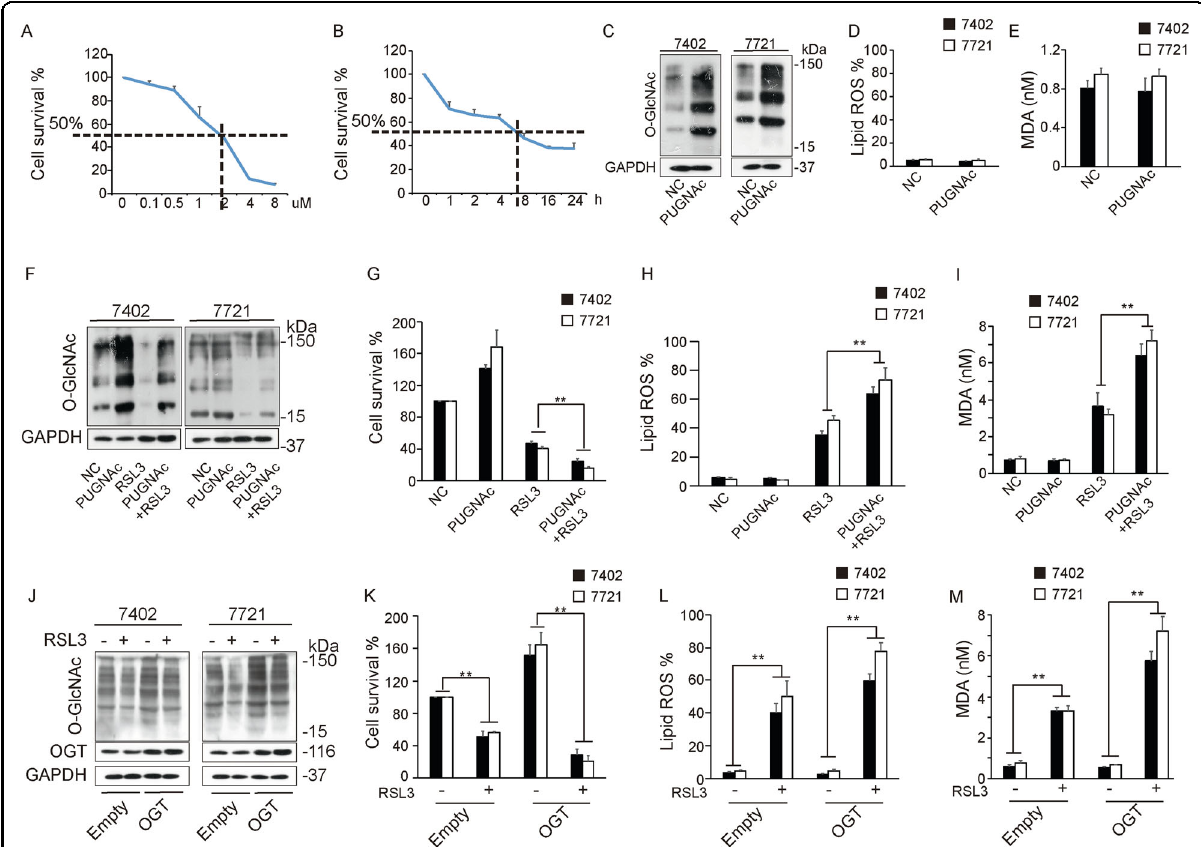
Fig. 1 O-GlcNAcylation increases ferroptosis sensitivity of HCC cells. A and B Cell viability was measured by an MTT assay in SMMC-7721 cells treated with RSL3 at the indicated concentration ( A ) and for the indicated time ( B ). C Global O-GlcNAcylation was measured by WB after PUGNAc treatment (25â €‰ µM). D The fl uorescence of C11-BODIPY was measured to detect lipid ROS in Bel-7402 and SMMC-7721 cells treated as indicated. E MDA levels were measured in Bel-7402 and SMMC-7721 cells treated as indicated. F Global O-GlcNAcylation was detected by WB in cells treated with PUGNAc and RSL3 separately or simultaneously. G – I Ferroptotic events were evaluated in cells treated with PUGNAc and RSL3 separately or simultaneously: cell death ( G ), lipid ROS production ( H ), and MDA production ( I ). J Global O-GlcNAcylation and OGT expression were detected by WB in Bel-7402 and SMMC-7721 cells overexpressing OGT. Cells were subsequently treated with RSL3 as indicated. K – M Ferroptotic events were evaluated in cells overexpressing OGT and treated with RSL3 as indicated: cell death ( K ), lipid ROS production ( L ), and MDA production ( M